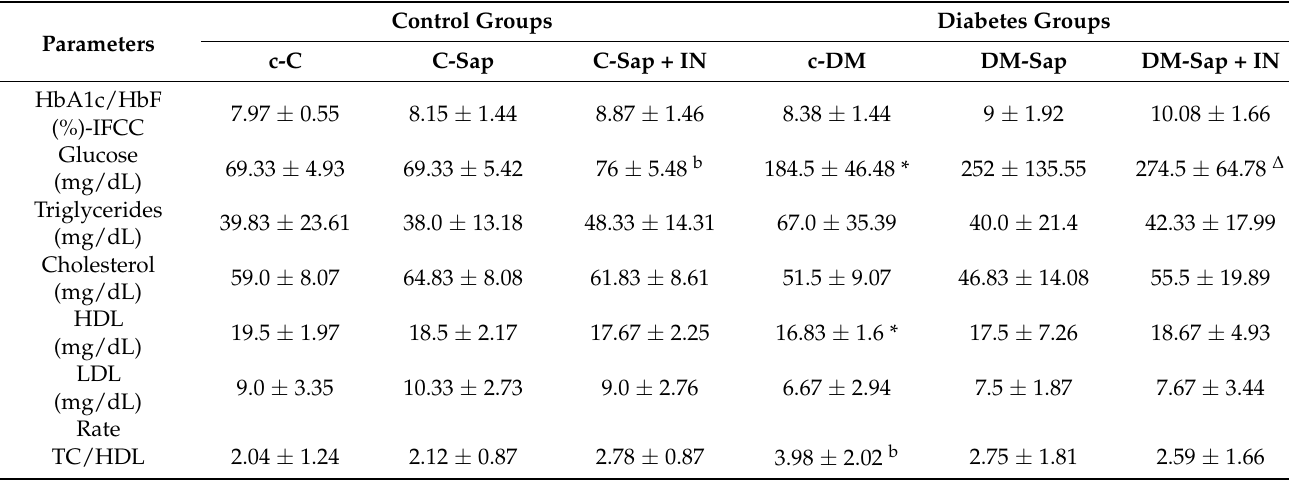
Table 2. The baseline plasma lipid profile, glycated hemoglobin, and glucose in each subgroup of rats. Control Parameters